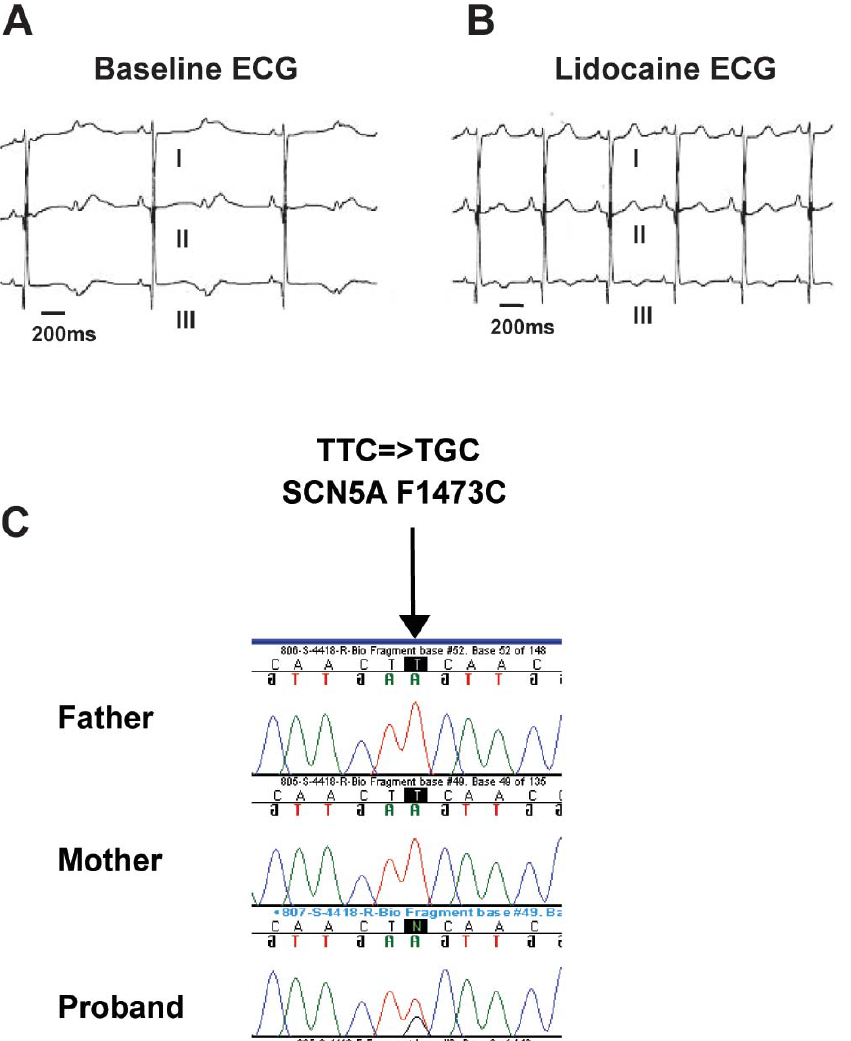
Figure 1. Clinical and genetic profile of the proband. A. Baseline ECG recording reporting a QTc of approximately 825 ms. Note 2:1 AV block. B. Recordingafter infusion with IV lidocaine (see text).QTcis approximately 450and2:1 block isabsent. C. Chromatograms of DNAsequences: theproband but neither the mother nor father has a 4418 T= . G in SCN5A resulting in a substitution of cytsteine for phenylalanine at amino acid 1473 in Na v 1.5.